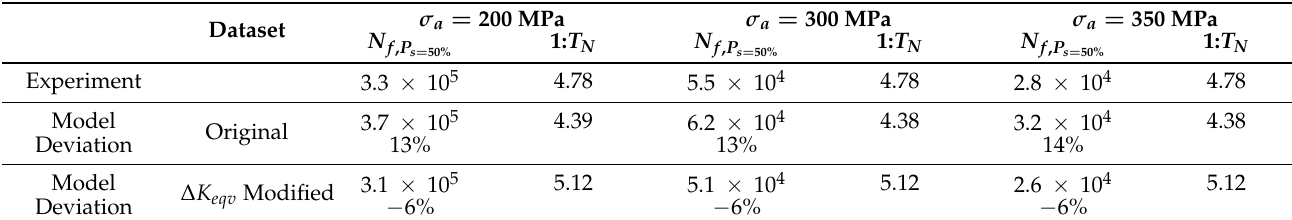
Table 7. Fatigue assessment model validation for constant stress amplitude.